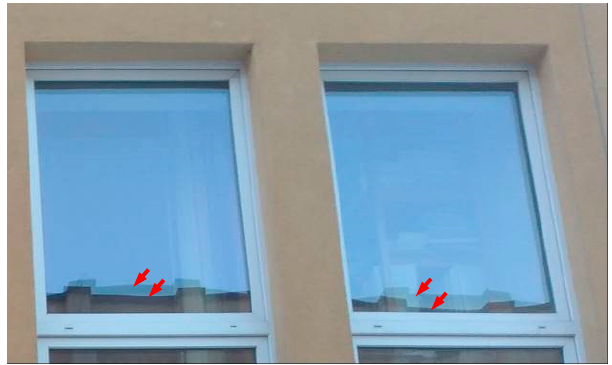
Figure 2. Visible distorted reflection of the image of the neighboring building from both insulating glass unit (IGU) component glass panes indicates the concave form of deflection of the unit.